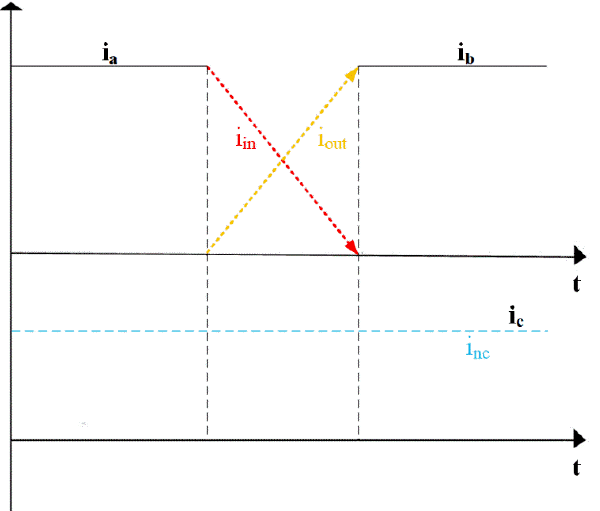
Figure 4. Commutating (in and out) and non-commutating current for a single commutation cycle. Commutating currents vary with the speed of the PMBLDC motor and have a variable value at each commutation cycle; thus, the value obtained from Equation (19) induces torque ripples at every commutating step when substituted in Equation (18). The variation of torque ripple in a PMBLDC motor when fed by a conventional VSI in an ideal and non-ideal setting is shown in Figure 5.